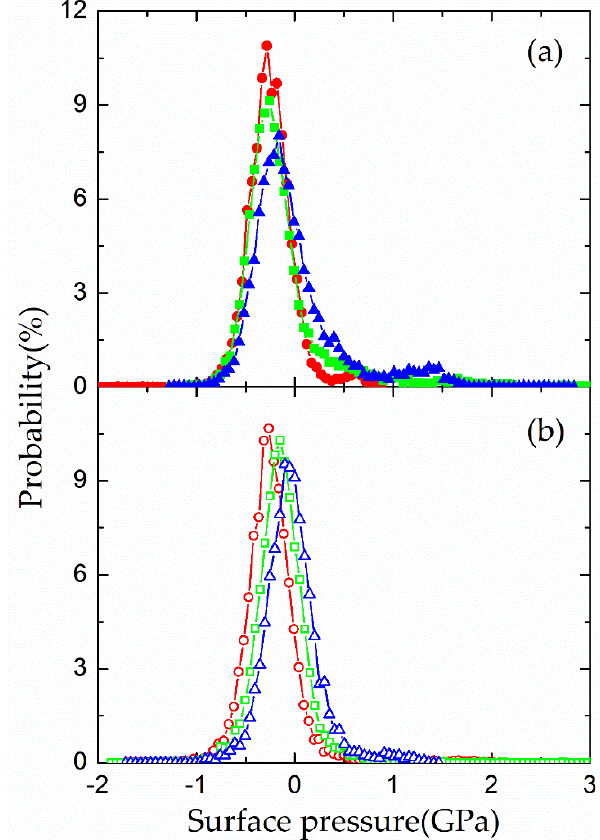
Figure 8. Pressure distribution in the dry contact ( a ) and 4000 molecules lubricated contact ( b ) under 0.05 GPa (red line), 0.15 GPa (green line) and 0.25 GPa (blue line).